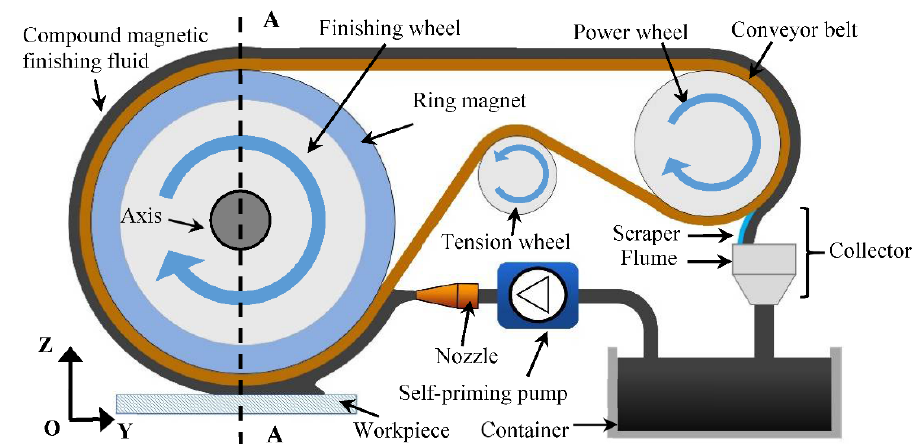
Figure 1. Schematic of the processing principle. Reprinted from Precision Engineering, 72, Xu J, Zou Y, Development of a new magnetic abrasive finishing process with renewable abrasive particles using the circulatory system, Pages No. 417-425, Copyright (2021), with permission from Elsevier.